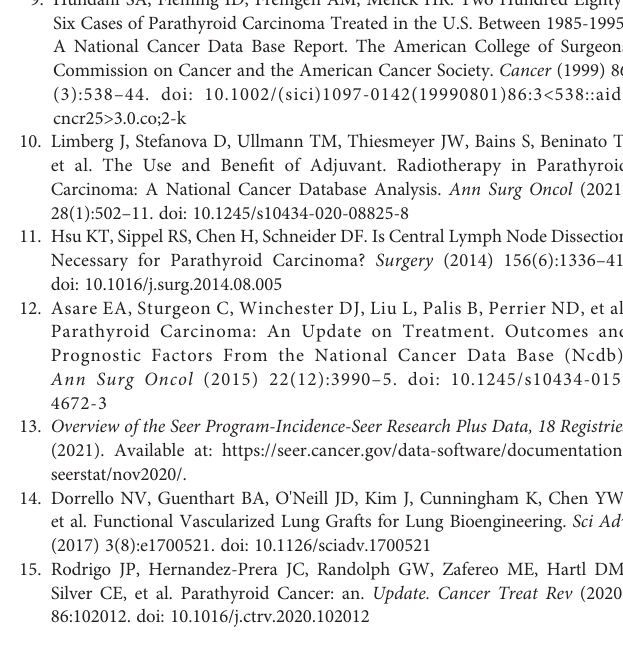
Supplementary Figure 1 | Kaplan-Meier survival curve demonstrating overall survival. Supplementary Figure 2 | Kaplan-Meier survival curve demonstrating cancer- speci fi c survival. Supplementary Figure 3 | Smooth curve fi tting showing the association between tumor size in millimeter and relative risk of cancer-speci fi c death in parathyroid carcinoma patient